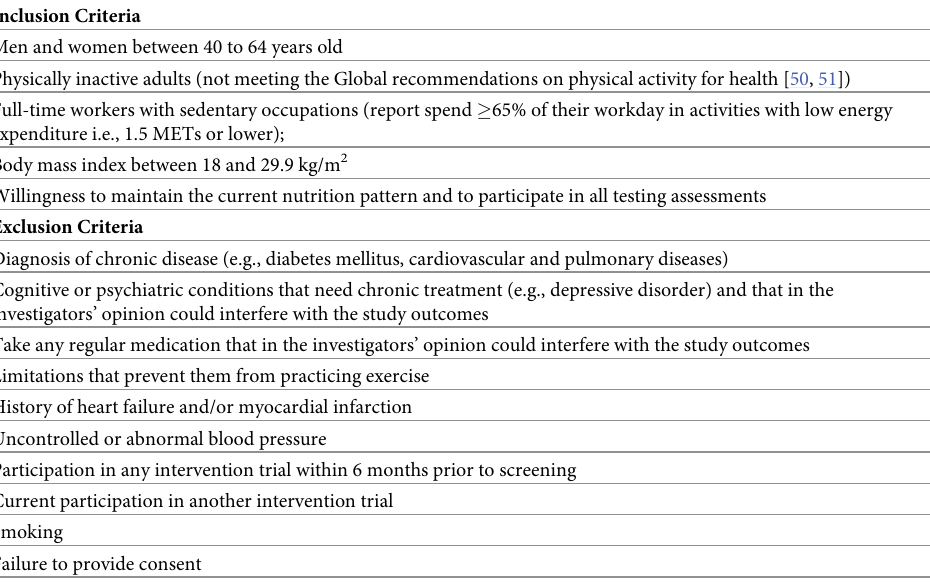
Table 1. Inclusion and exclusion criteria for